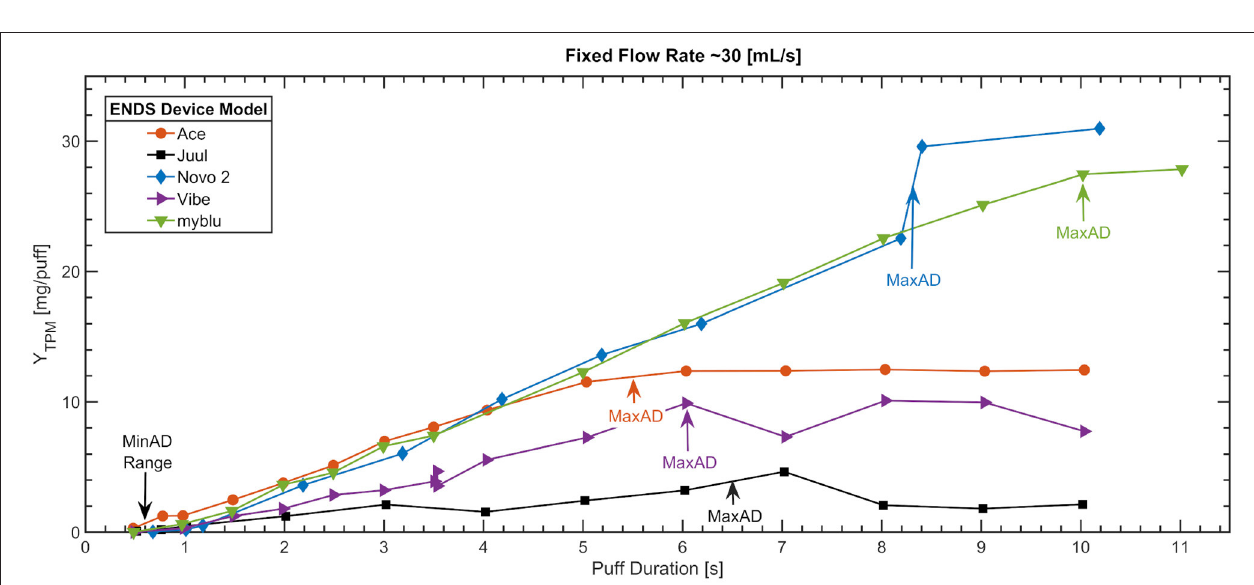
FIGURE 3 | Minimum and maximum activation duration, MinAD and MaxAD, for 5 of the 13 ENDS devices tested. Shown is the mean TPM yield per puff for each duration condition, based on nominally 50 puffs per flow rate conditions. Puffs were square-wave and nominally 30 ml/s, with 30s period.